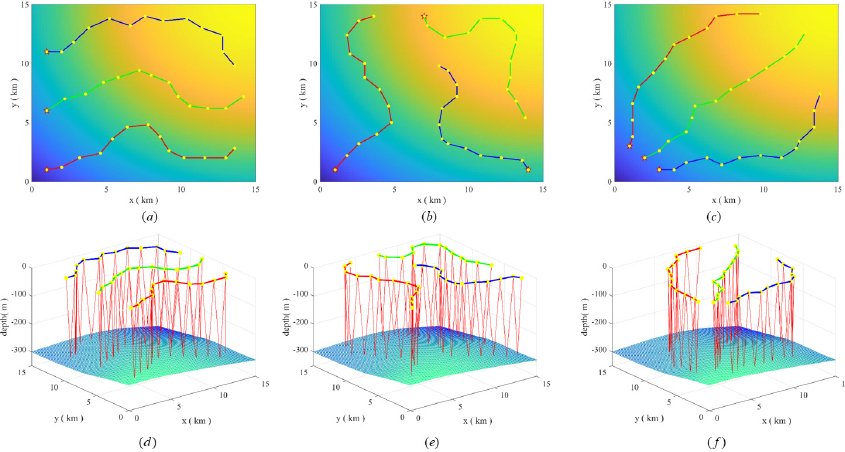
Figure 8. The MGCPP − ACO algorithm path planning results in scenario 2 (where ( a – c ) are 2D plane trajectories, and ( d – f ) are 3D space trajectories).